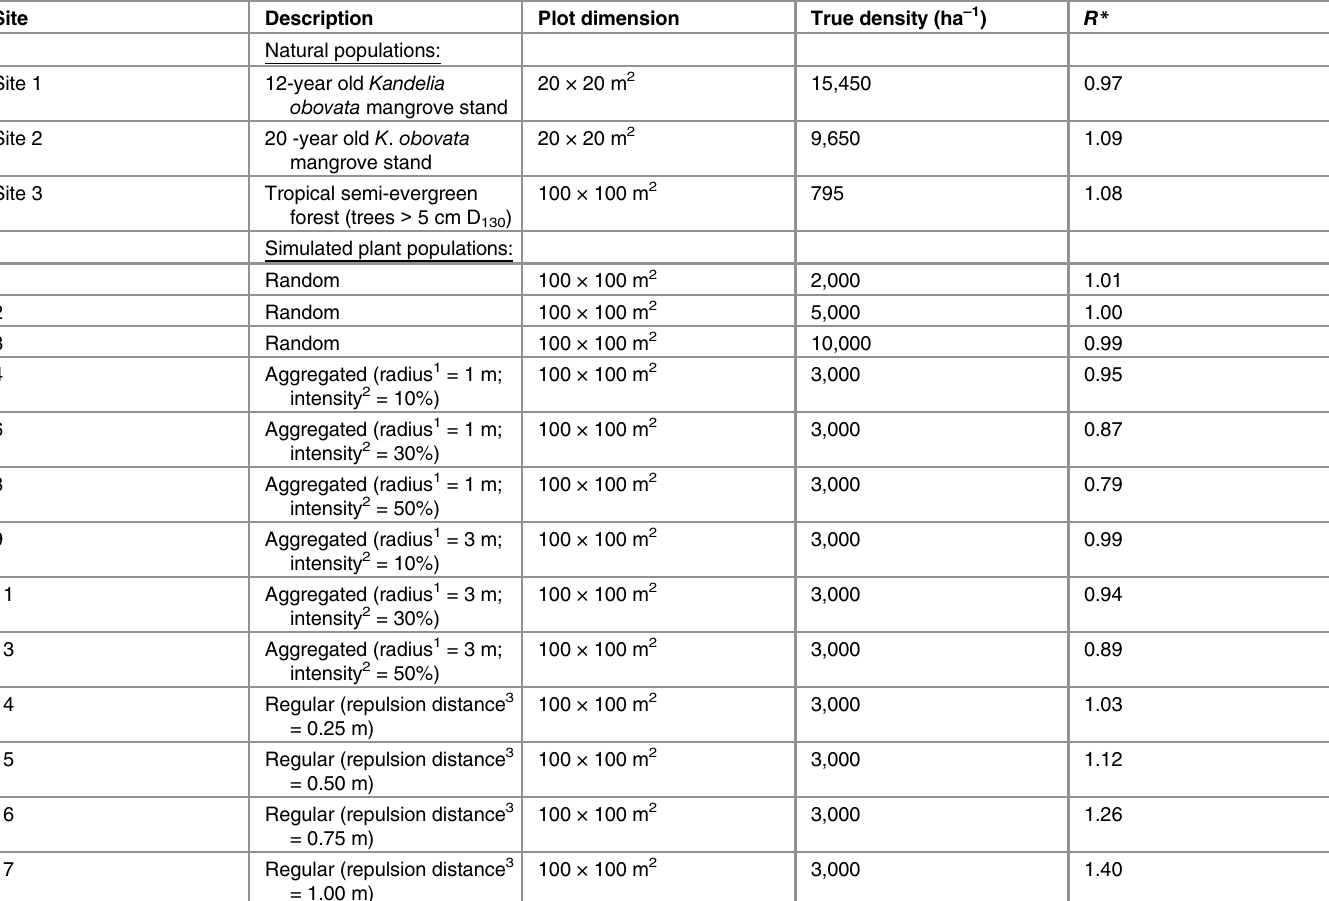
Table 1. Characteristics of simulated and empirical datasets having different spatial